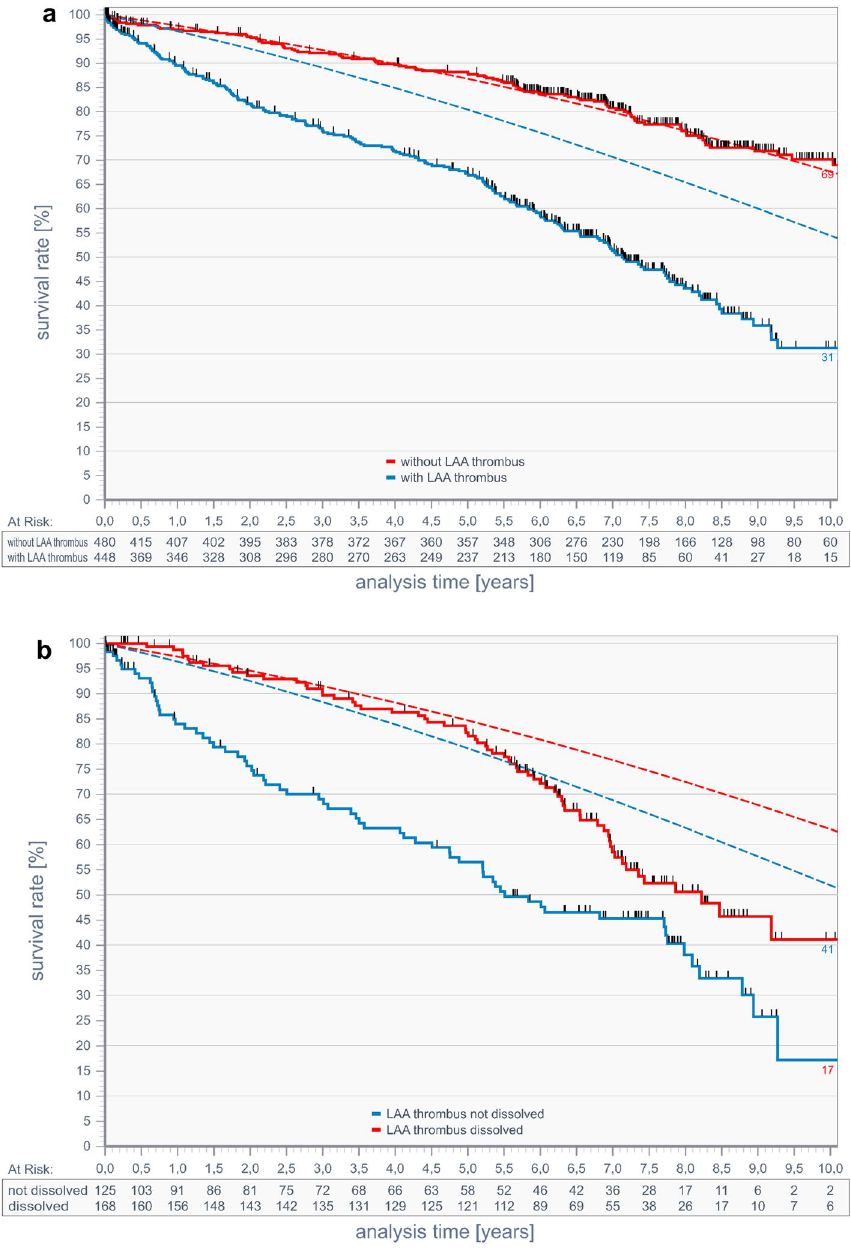
Figure 4. Comparison of all-cause mortality of patients without (red line) and with LAA thrombi (blue line). Dotted lines represent estimated all-cause mortality of an age-and sex-matched general population in Germany corresponding to each of the two groups ( a ). Comparison of all-cause mortality of patients who did not dissolve LAA thrombi (blue line) and of patients who dissolved LAA thrombi (red line). Dotted lines represent estimated all-cause mortality of an age-and sex-matched general population in Germany corresponding to each of the two groups ( b